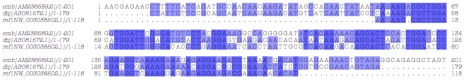
Alignment of the LINE-like upstream region in Mghsp90.Upstream sequenceis identical in both genes, Mghsp90-1 is shown only (AM236589.2), and similar to the LINE-like Gamera element in O. curvinotus (AB081572.1) and S. mansoni (NW_003038502.1). Identities in all sequences are represented as dark blue boxes and in two sequences in light blue boxes. Alignment visualized by JalView [91]. Sequence positions are relative to the alignment and do not correspond to those of the database entries.